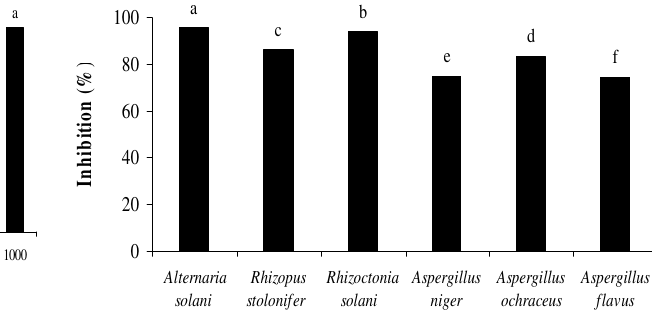
Fig. 2. Effect of Zataria multiflora essential oil on the inhibition percentage of fungus Alternaria solani , Rhizoctonia solani, Rhizopus stolonifer , Aspergillus flavus , Aspergillus ochraceus and Aspergillus niger . Different letters above columns indicate significant differences according to Duncan’s multiple range tests at P ≤ 0.01